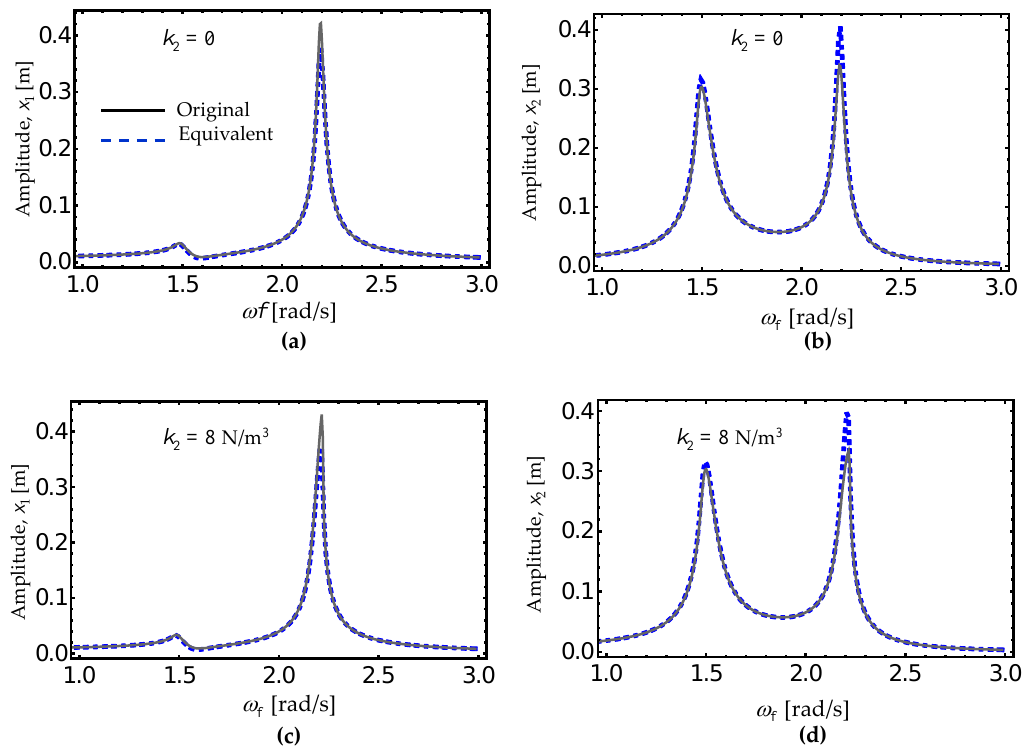
Figure 10. Frequency-amplitude response curves computed from the numerical integration solutions of Equations (29) and (43). The parameter values used to obtain these plots were 𝑚 1 = 10 kg, 𝑚 2 = 0.8 kg, 𝑐 1 = 0.1 Ns/m, 𝑐 2 = 0.08 Ns/m, 𝑘 1 = 44 N/m, 𝑘 3 = 2 N/m, 𝑘 4 = −0.65 N/m 3 , 𝑓 0 = 0.37 N, and ( a ) x 1 vs ω f , and ( b ) x 2 vs ω f with k 2 = 0; ( c ) x 1 vs ω f , and ( d ) x 2 vs ω f with k 2 = 8 N/m 3 . Here, the black, solid lines describe the numerical integration solution of Equation (43), while the blue, dashed lines represent the numerical solutions obtained from the derived equivalent nonlinear equations of motion (29).